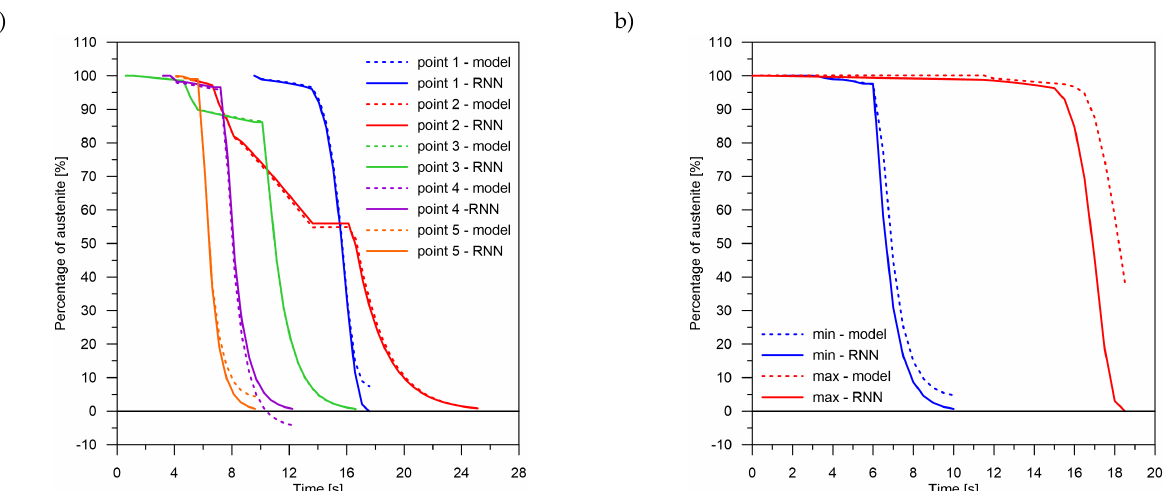
Figure 12. Kinetics of transformations: a comparison of the analytical model with the RNN model for case No. 5.